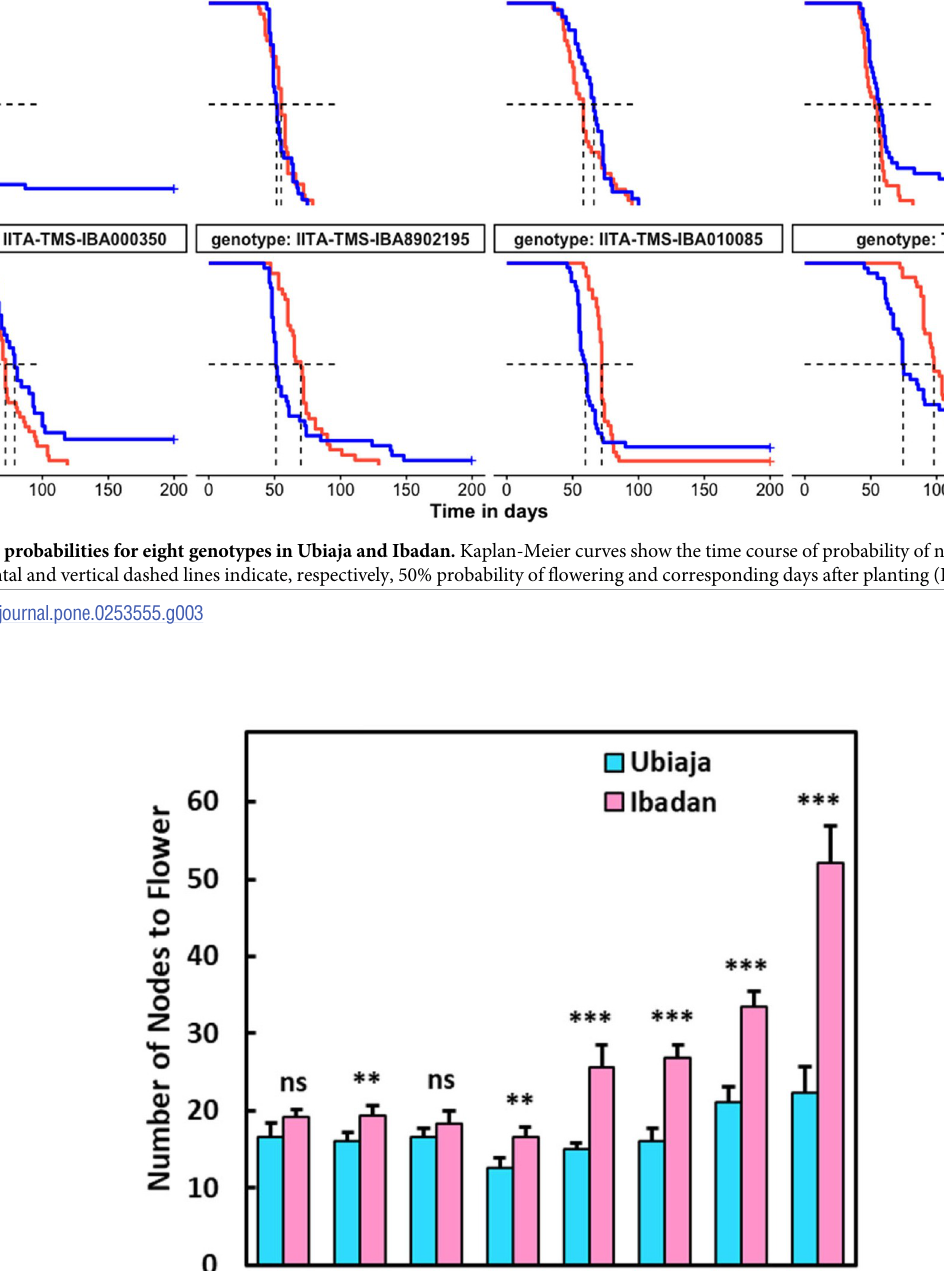
PLOS ONE | https://doi.org/10.1371/journal.pone.0253555 July 21,